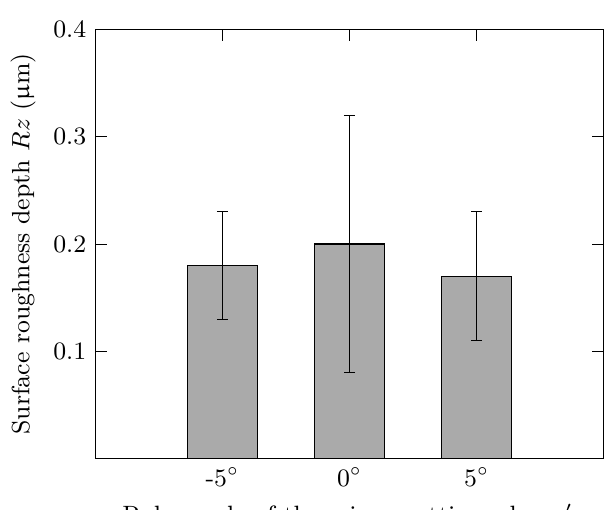
Figure 10. Surface roughness depth Rz for different rake angles γ (cid:48) o of the minor cutting edge ( v c = 250m/min, f z = 0.015mm, a p = 0.25mm, a e = 0.5mm, α (cid:48) o = 2 ◦ ).